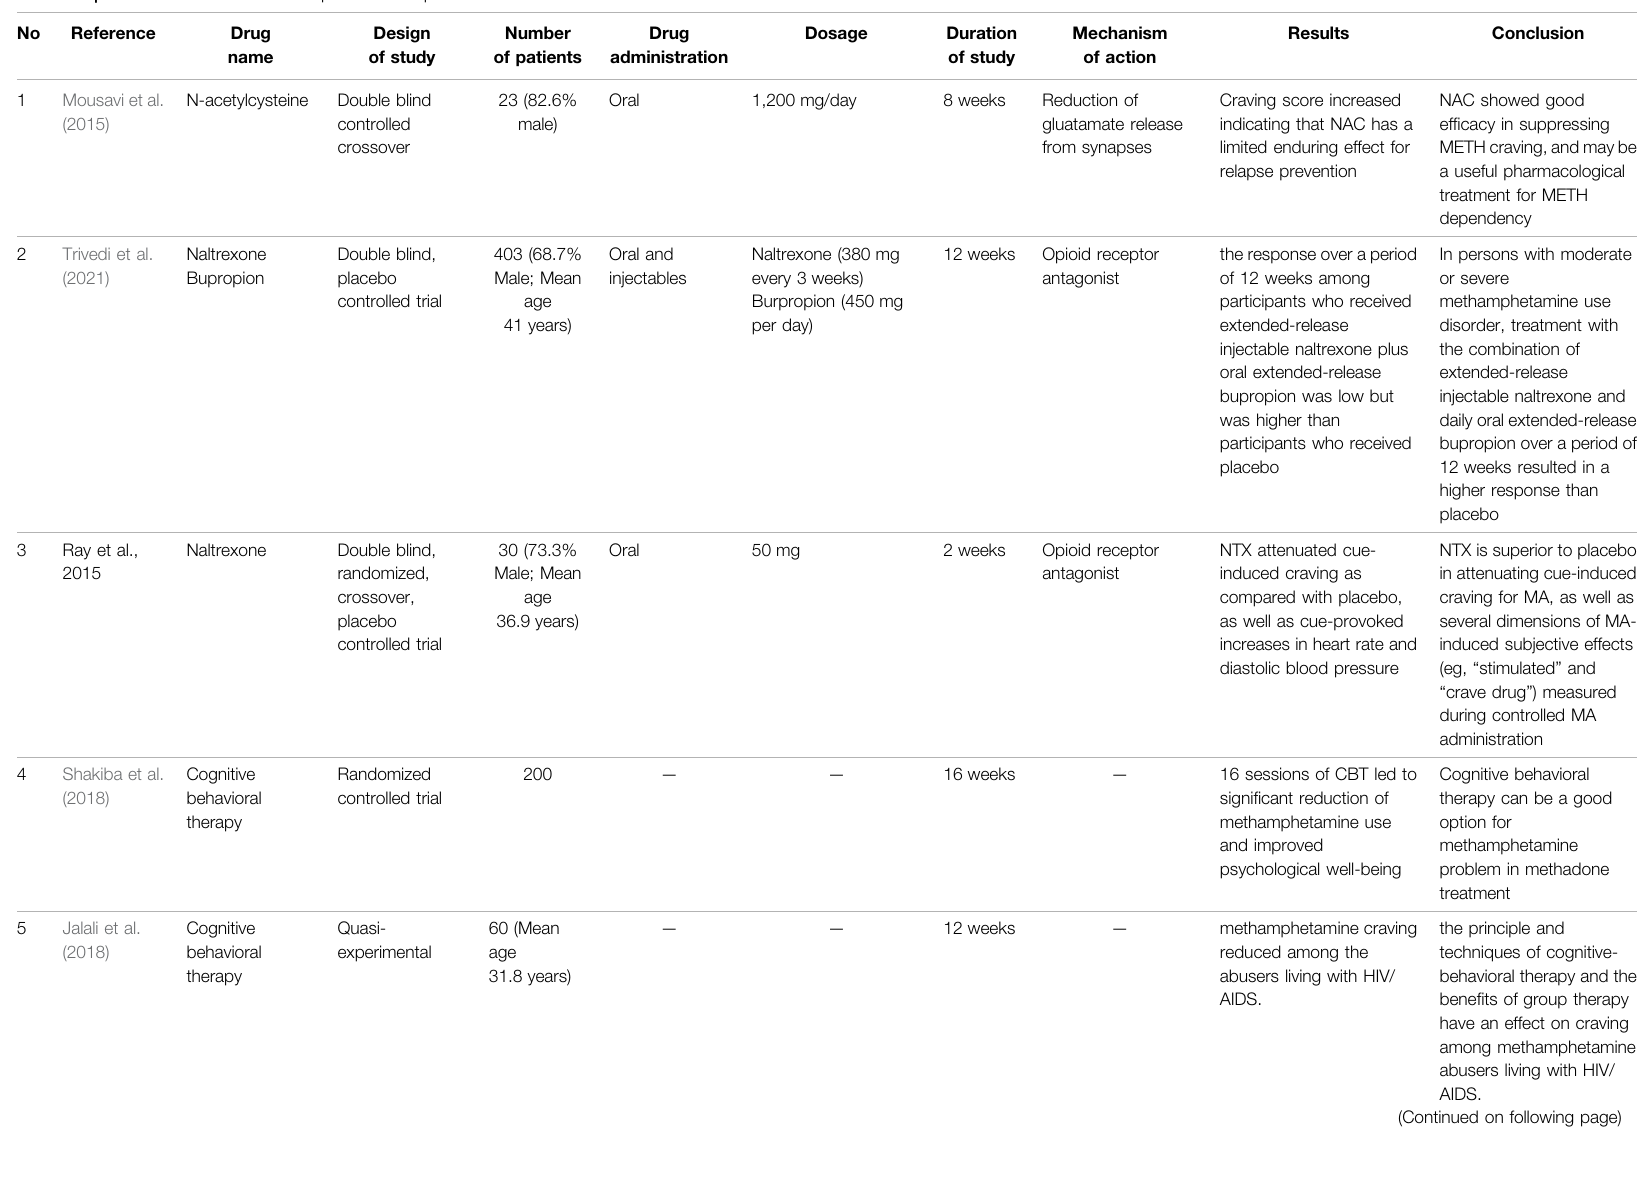
TABLE 2 | Current treatment in methamphetamine